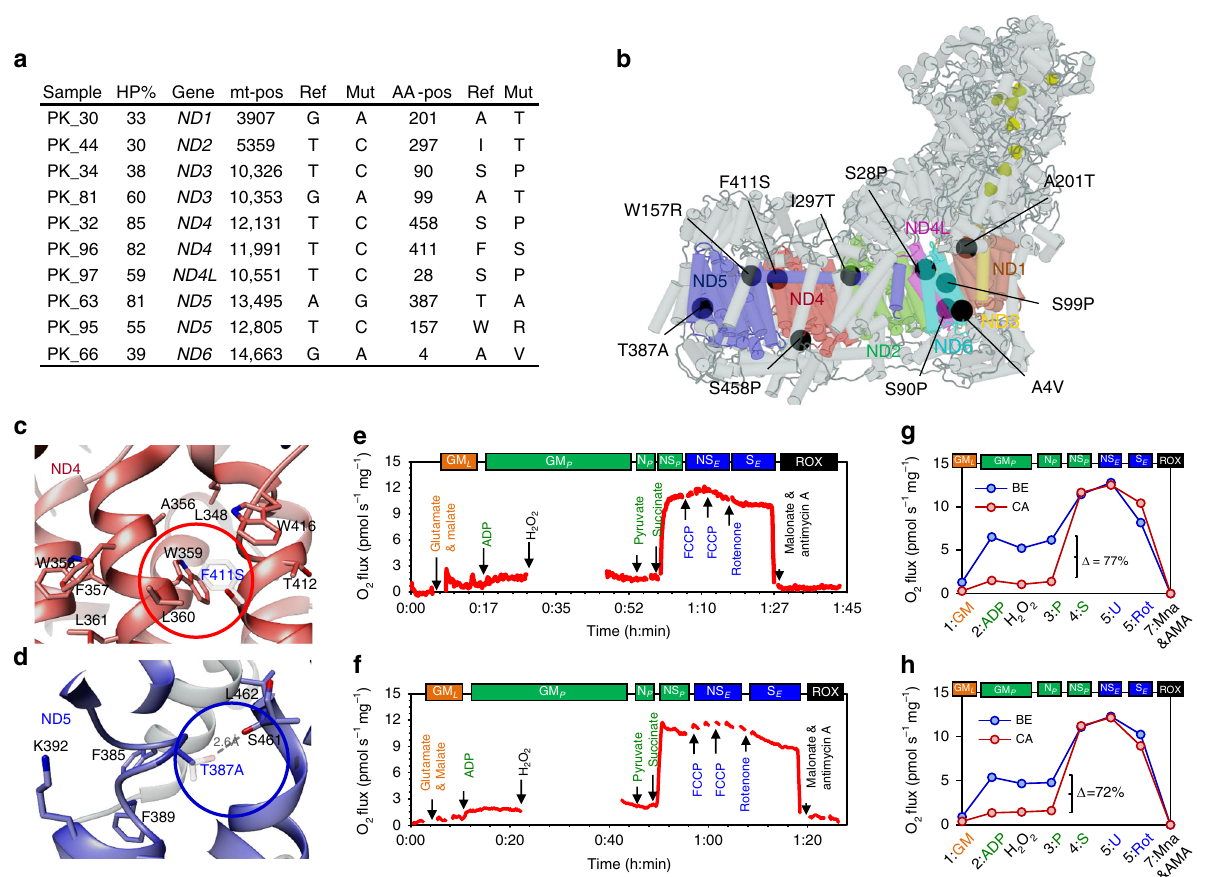
Fig. 5 Structural impact of non-synonymous CI gene mutations. a List of malignant samples carrying non-synonymous variants with HP levels ≥ 30% (HP % = heteroplasmy levels, Gene = mt-gene, mt-pos = location of variant on mtDNA sequence, Ref = nucleotide in rCRS sequence, Mut = altered nucleotide found in sample, AA-pos = position of encoded amino acid in protein sequence, Ref = amino-acid in wild-type protein, Mut = altered amino acid). b Structure of human respiratory Complex I and location of mutations found in this study. mtDNA-encoded CI-subunits (ND1-6) are shown in colors (ND1 = dark red, ND2 = light blue, ND3 = orange, ND4 = red, ND4L = purple, ND5 = dark blue and ND6 = light blue), mutations are shown as black circles and Fe-S clusters as yellow spheres. To visualize mutation sites see complemental iSee package using any JavaScript enabled web browser ([https://github.com/ genepi/mt-c1]). c Structural change caused by the F411S mutation (red circle) in ND4. Wild-type (F) and mutated variant (S) amino acids are depicted and superimposed together with amino-acid residues involved in the hydrophobic interaction network of the α -helix structure (W359, L360, and W416, respectively). d Structural change caused by the T387A mutation located within the loop of the discontinuing helix 12 in the central axis of CI membrane domain (blue circle) in ND5. Wild-type (T) and mutated variant (A) are superimposed and the stabilizing hydrogen bond present in the wild-type protein is depicted by a scattered line. e – f HRR traces of the malignant biopsies carrying the F411S (e) or the T387A mutation (f), respectively. The red line represents wet mass-speci fi c O 2 fl ux (oxygen consumption (pmol s − 1 mg − 1 ]). g – h Respiratory capacities of malignant samples (red) carrying either the F411S mutation ( g ) or the T387A mutation ( h ), compared to the corresponding benign tissue (blue). Values represent mean ± SD of the two separate measurements for each tissue sample. See Fig. 2 and Supplementary Tables 1 – 2 for abbreviations, coupling states and SUIT